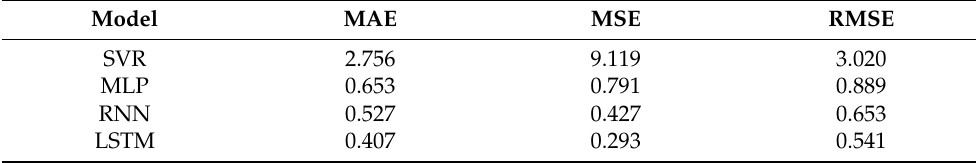
Table 5. GDEA prediction results.